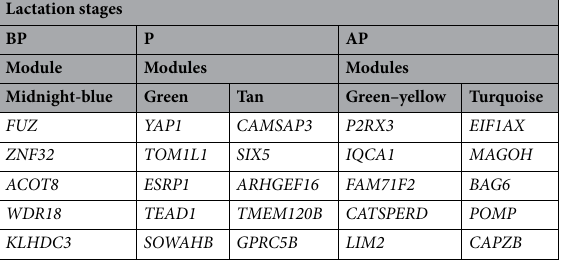
Table 2. Hub genes in significant modules at BP, P and AP stages of lactation.